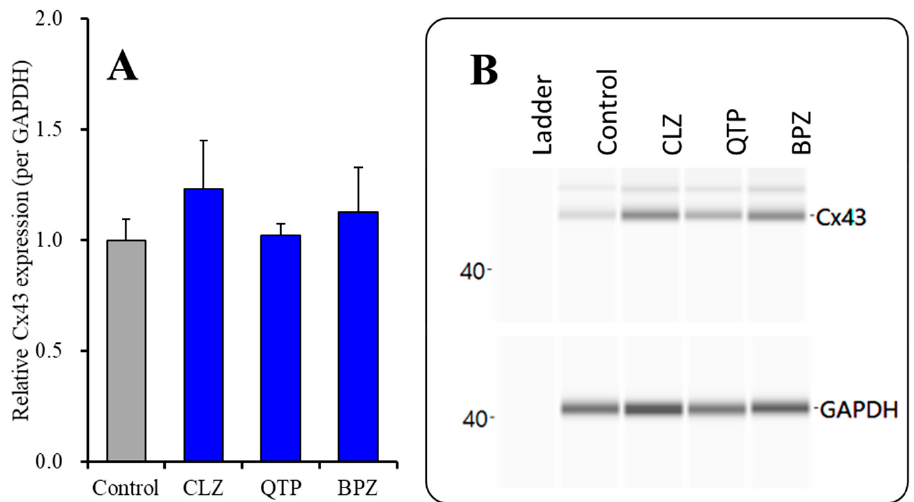
Figure 6. Effects of subchronic administration of therapeutic-relevant concentration of antipsychotics, CLZ (3 µ M), QTP (1 µ M) and BPZ (0.3 µ M), on Cx43 protein expression in the plasma fraction ( A ) and their pseudo-gel images, using capillary immunoblotting ( B ). Ordinate: mean ± SD ( n = 6) of the relative protein level of Cx43 (per GAPDH).